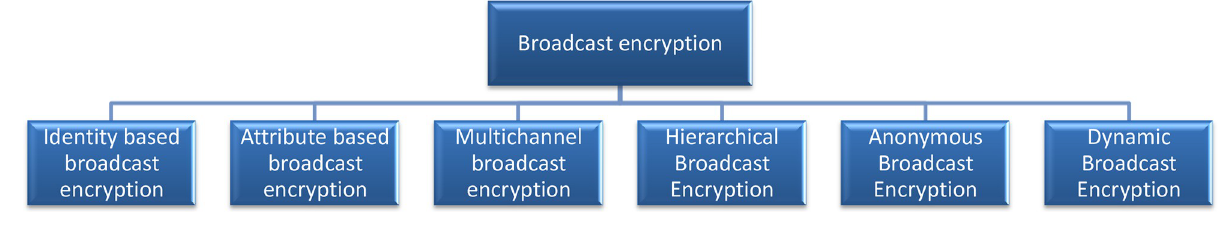
Fig 1. Broadcast encryption in public key